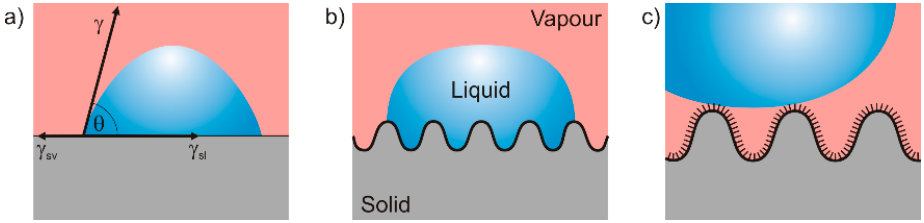
Figure 2. Wetting states ( a ) Young; ( b ) Wenzel; and ( c ) Cassie-Baxter.